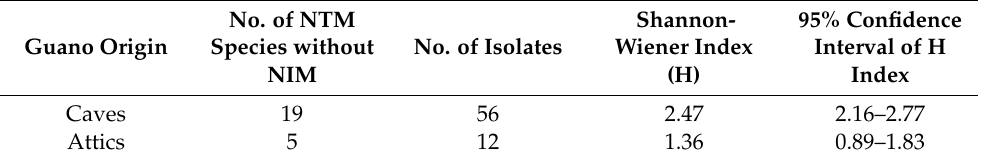
Table interpretation. CFU = colony forming units; TNTC = too numerous to count. Table 8. Nontuberculous mycobacteria detection by qPCR in caves’ and attics’ bat guano samples.